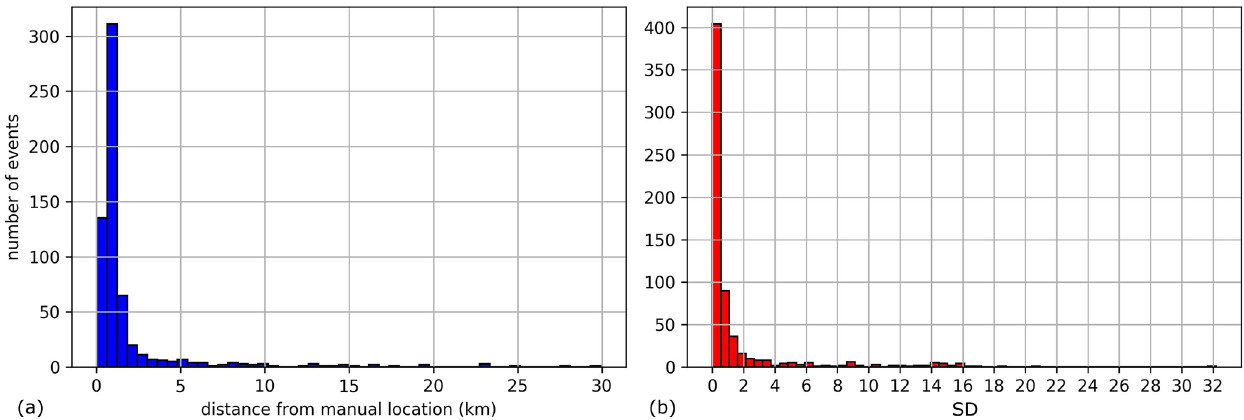
Figure 6. Histogram plots show (1) the number of events automated located (blue bars) within a given distance from the manual locations (a) and (2) standard deviation of results (red bars, b